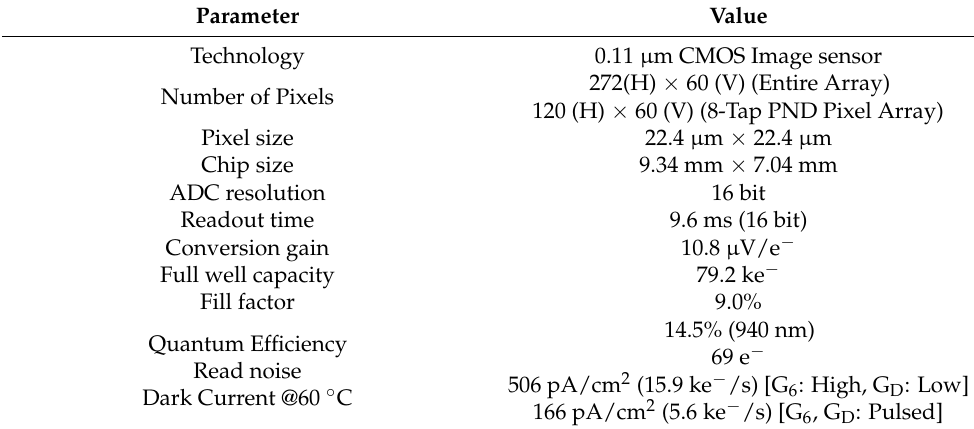
Table 1. Summary of the prototype CMOS imager